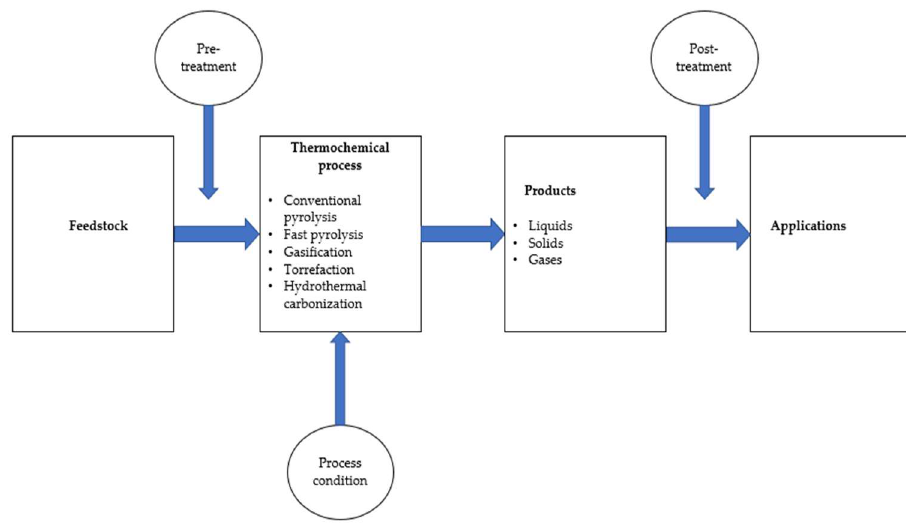
Figure 2. Factors that affect how char is produced and used.